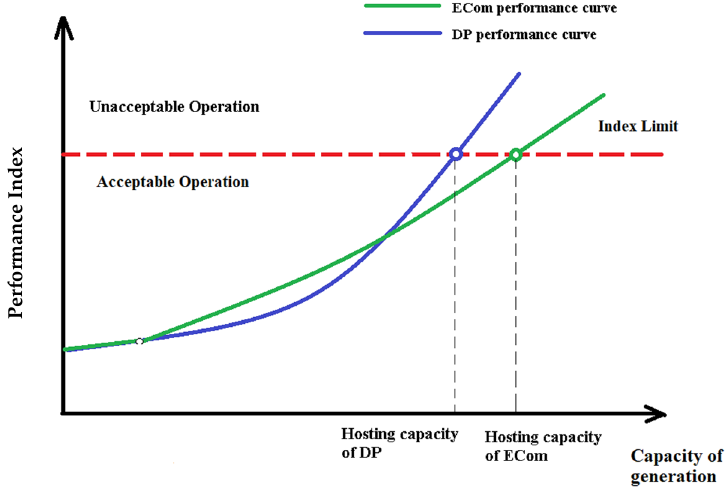
Figure 2. ECom and DP performance curve of HC.